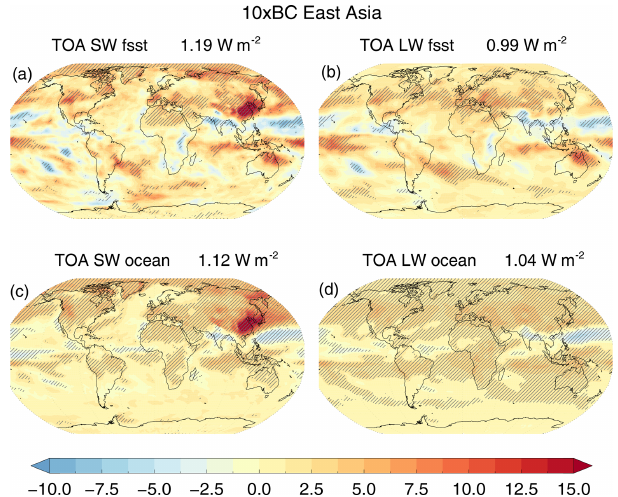
Figure 5. Change in delta TOA net SW and LW radiative fluxes (sum of downward and upward) for the 10 × BC in East Asia per- turbation minus the baseline. The top row shows the runs with fixed SSTs, and the bottom row shows the runs with a fully coupled ocean. The stippled areas represent statistically significant changes ( p< 0 . 05).